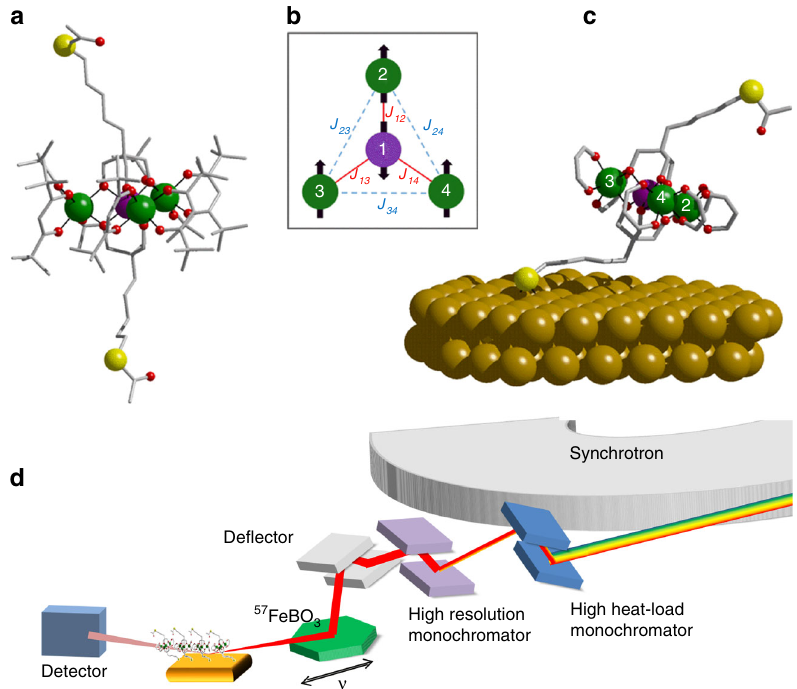
Fig. 1 Structure of the investigated systems and experimental setup. a Structure of Fe 4 SMM in the crystalline phase (color code: Fe atoms in green and violet, O in red, S in yellow, C as pale gray sticks, H atoms omitted for clarity); b scheme of the magnetic core, where the dominating antiferromagnetic interactions (in red) lead to an S = 5 ground state; c view of the structure of the Fe 4 SMM tethered to Au(111) through the deprotected thioacetyl termination, as obtained by ab initio molecular dynamics calculations 26 . Hydrogen atoms and tert -butyl groups on dpm – ligands have been omitted for clarity; d scheme of the experimental setup of the Synchrotron Mössbauer Source at the ID18 beamline of